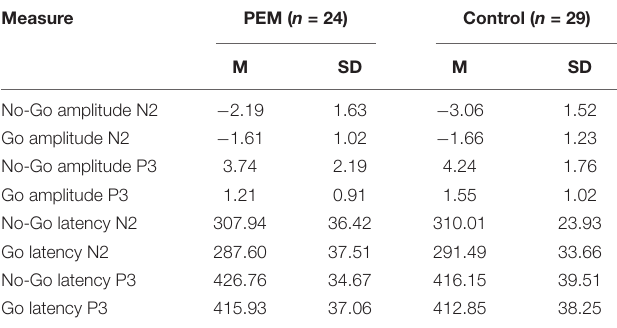
TABLE 5 | Mean and standard deviation of the ERP measures for Cz